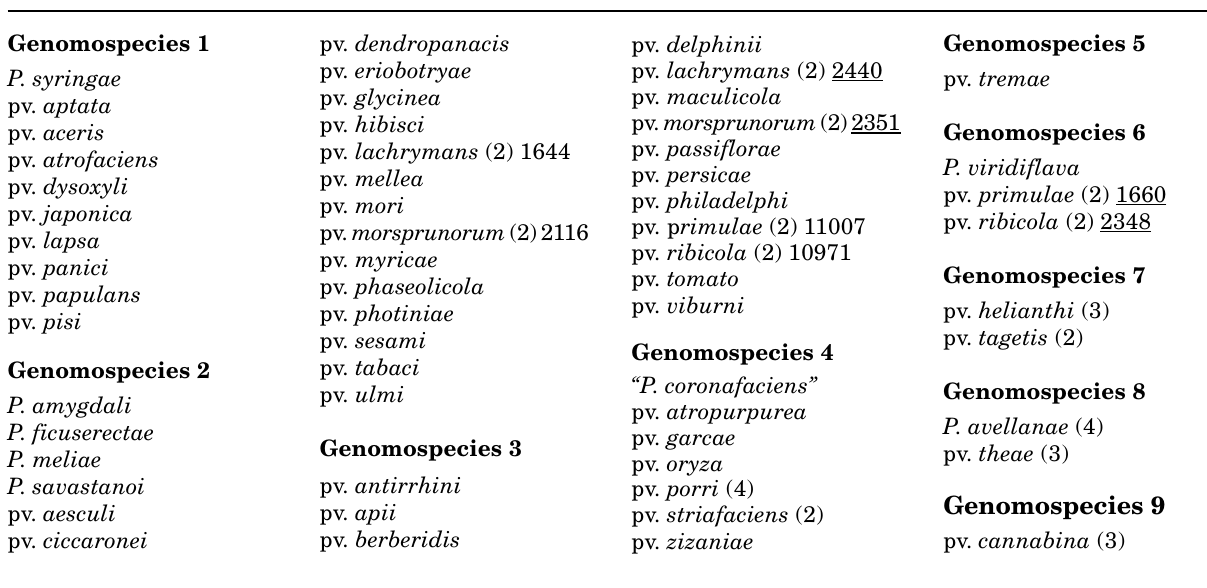
Table 2. Proposed distribution in genomospecies of Pseudomonas syringae pathovars and related Pseudomonas species a